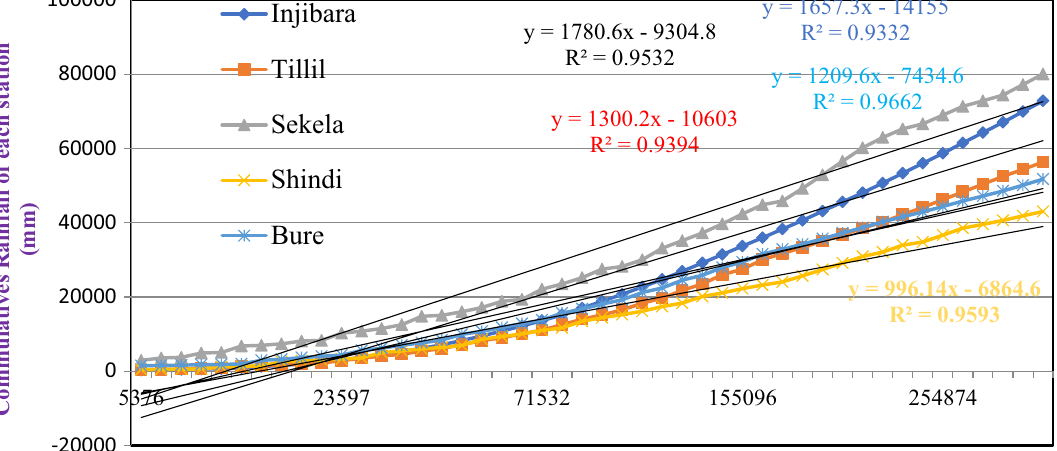
Fig. 6 Consistency checking of the five rainfall stations within and around the